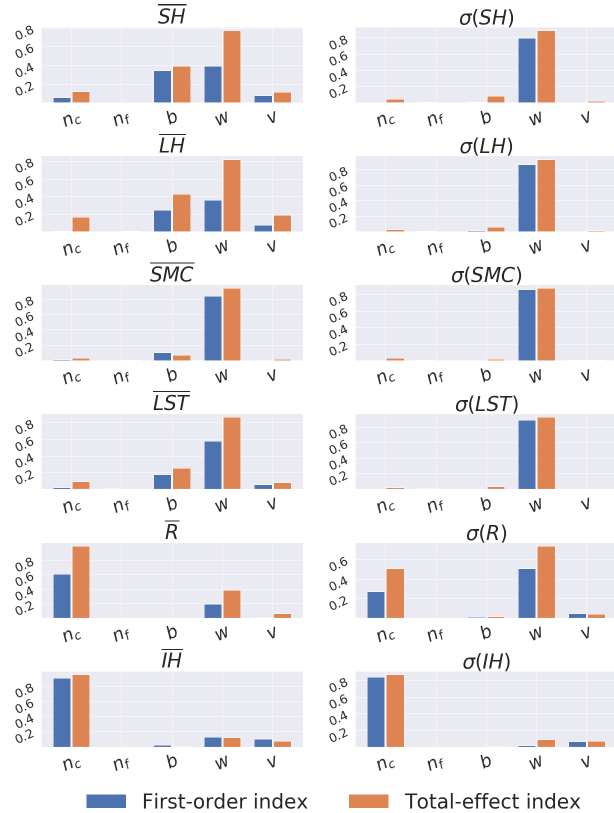
Figure 12. First-order ( S i ) and total-effect sensitivity ( S Ti ) indices from the Sobol sensitivity analysis of the n c (channel Manning’s roughness coefficient), n f (floodplain Manning’s roughness coeffi- cient), b (channel bankfull depth), w (channel width), and v (uni- form overland flow velocity) parameters in the HydroBlocks land surface model over the SGP site in Oklahoma. The explored simu- lated variables are the same as those in Fig.